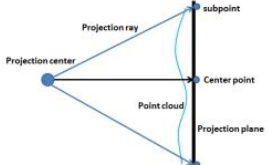
Secondly, the right angle coordinate system of projection plane space is established. Calculate the minimum outer rectangle of all projection points in the projection plane, take the upper-left corner of the rectangle as the origin of the axis O, the eastward direction of the minimum outer rectangular edge from the origin is an axis X, to the south is the axis Y, vertical plane XOY as axis Y. Establishment of Spatial Cartesian coordinate system of projection plane O-XYZ.As shown in figure 2.The spatial linear equations of the OX axis and the OY axis are obtained under the coordinate system of the 3D laser scanner.